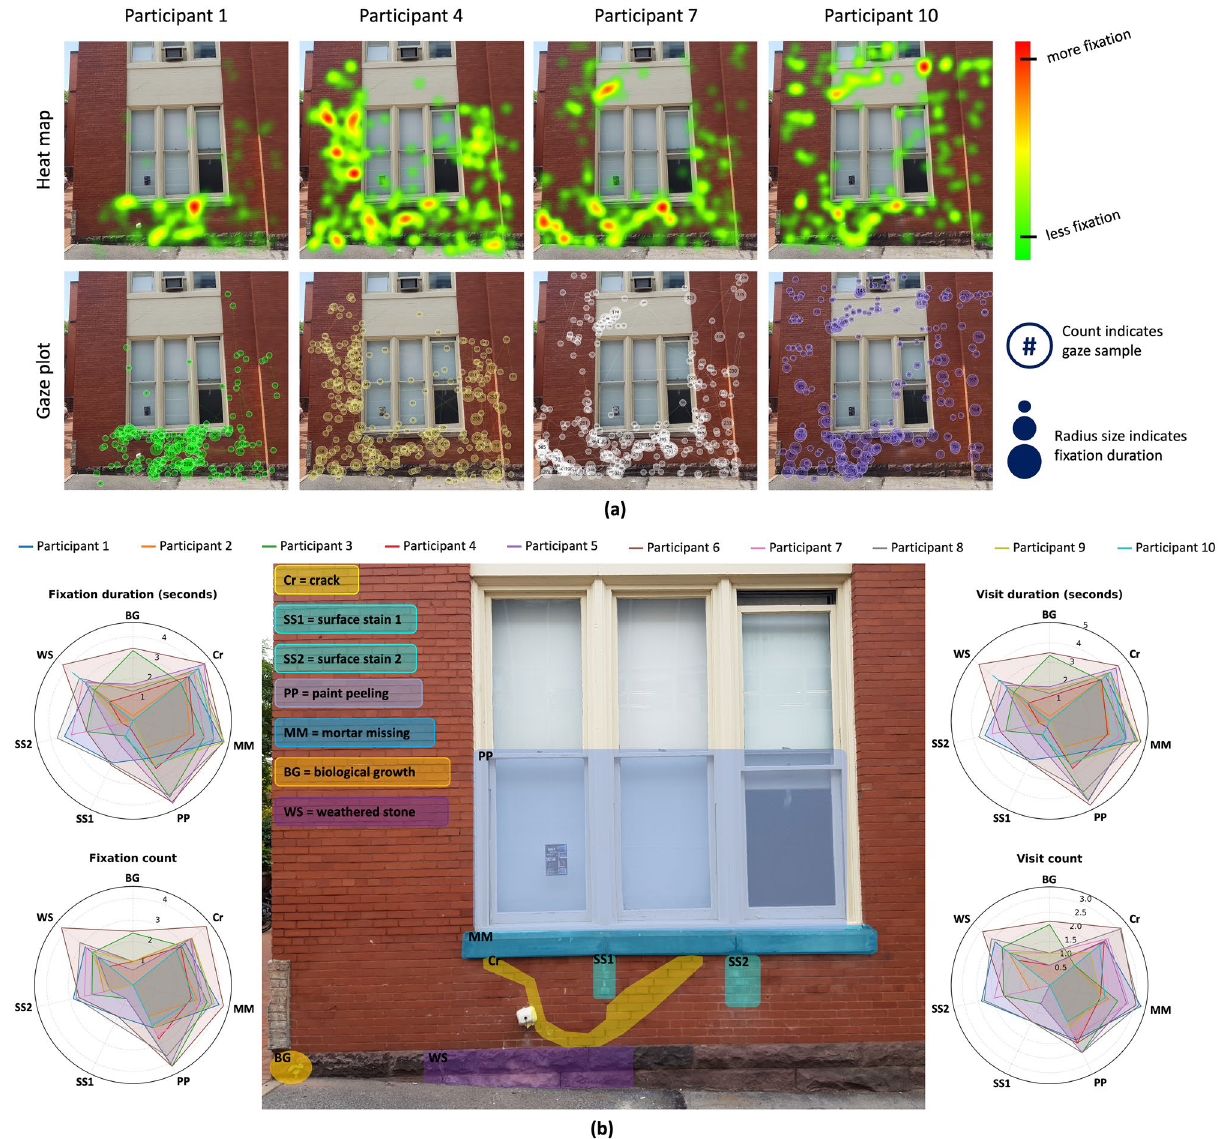
Figure 2. Results of participants data for Building 1 ( a ) Comparison among heat maps and gaze plots of participants ( n = 4 in visual for simplicity; n total = 10), ( b ) Comparison of participant’s eye tracking movements based on damage typology i.e., fixation duration(seconds), fixation count, visit duration (seconds), visit count; legend identify 10 candidates participated in the